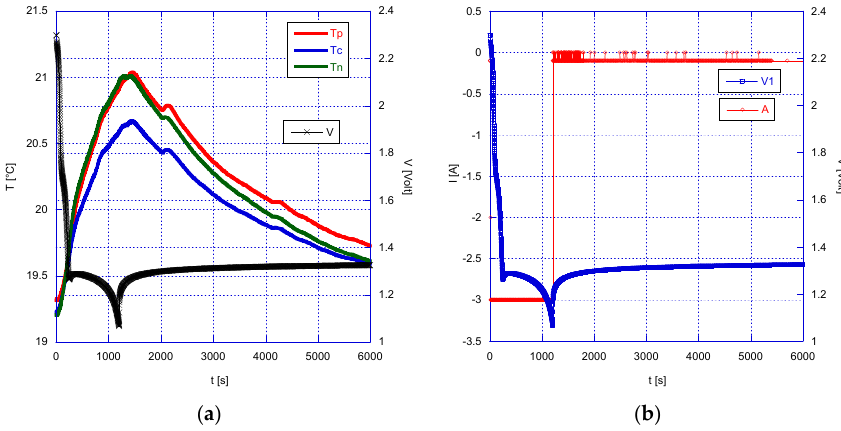
Figure 12. LTO cell. Overdischarge test, DOD% = 110%: ( a ) temperature and voltage trend of the abused cell, ( b ) current and voltage trends of the abused cell. After a long break, the cell was recharged: during the charge the cell didn’t show any anomalies and drew current with no problems, reaching a voltage value of 2.4 V after